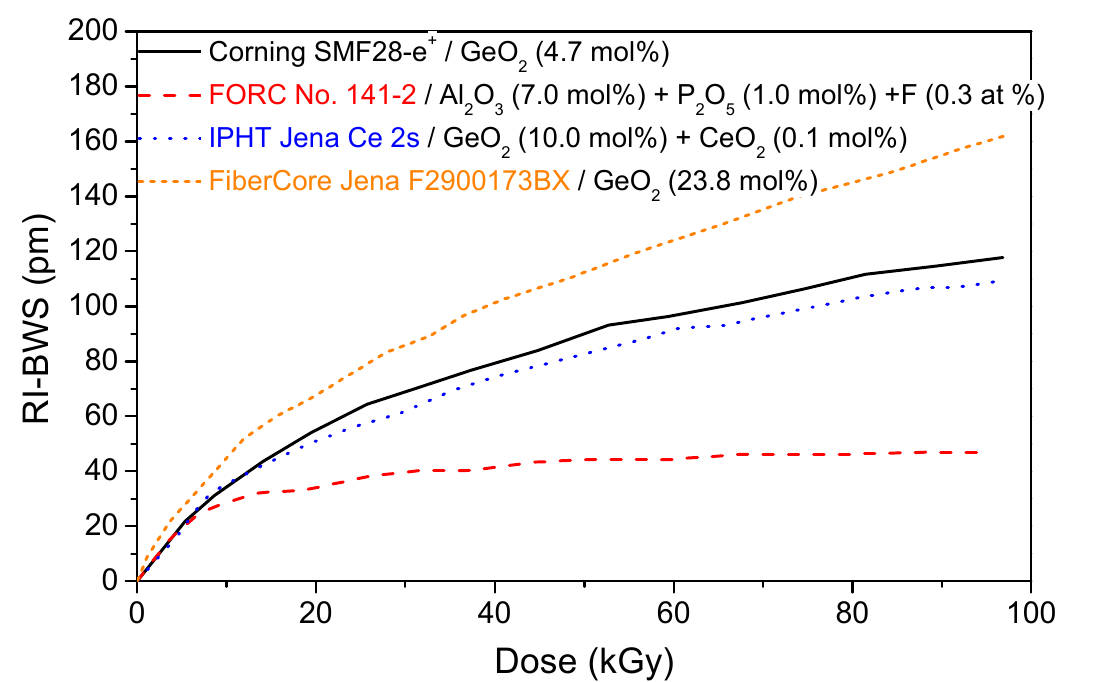
Figure 4. BWS induced by γ -rays on type I-UV gratings, written by different manufacturers on uncoated fibers with different core compositions that were recoated after inscription, the dose rate being 0.9 Gy/s up to 100 kGy at RT. Data extracted from [76].